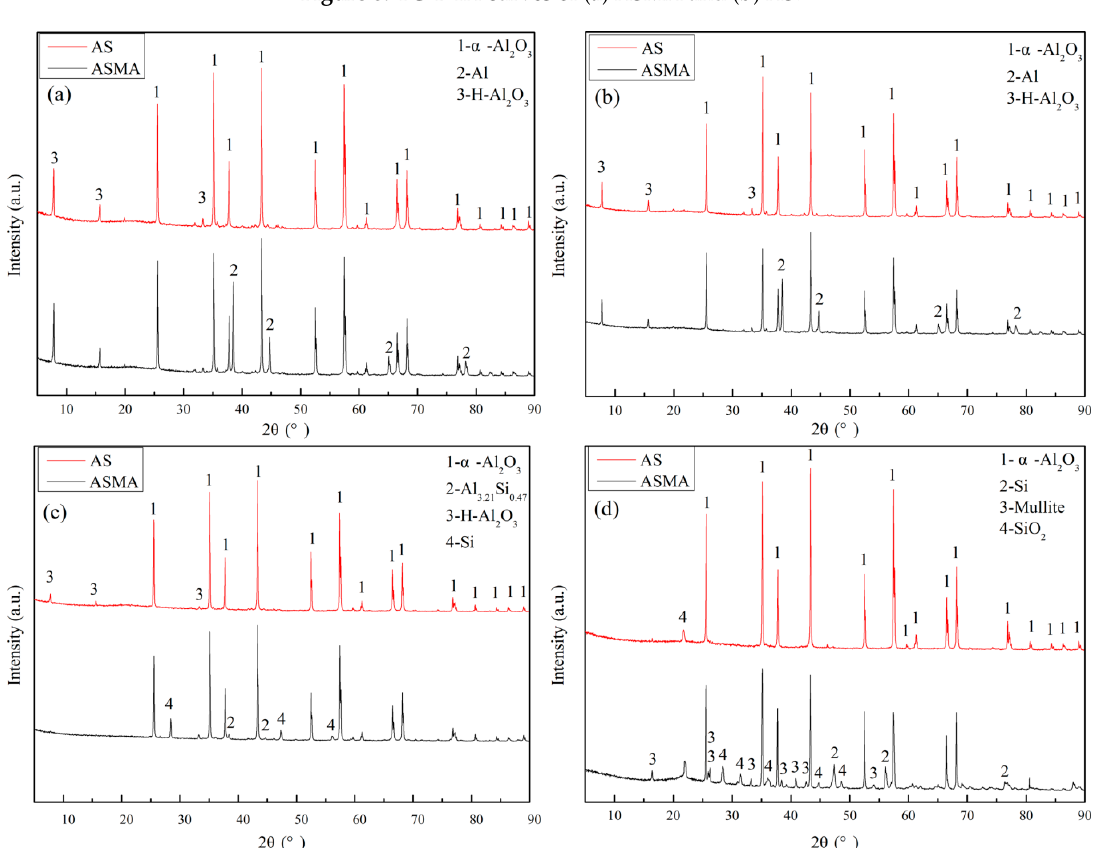
Figure 9. Comparisons of XRD result of the sample protected by ASMA and AS slurry at dffierent temperatures: ( a ) 500 °C, ( b ) 800 °C, ( c ) 1100 °C, ( d ) 1250 °C.